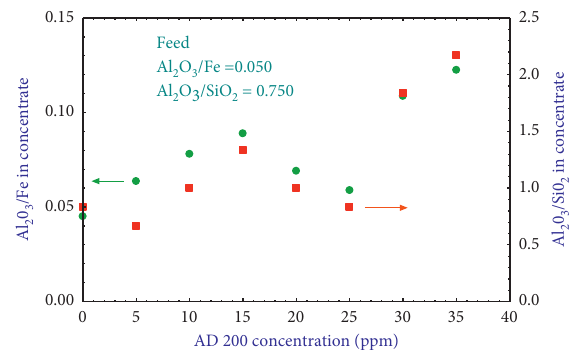
Figure 9: Al 2 O 3 /Fe and Al 2 O 3 /SiO 2 ratios in the concentrate from 25 wt. % slurry of slime at different doses of AD 200 at pH 8.